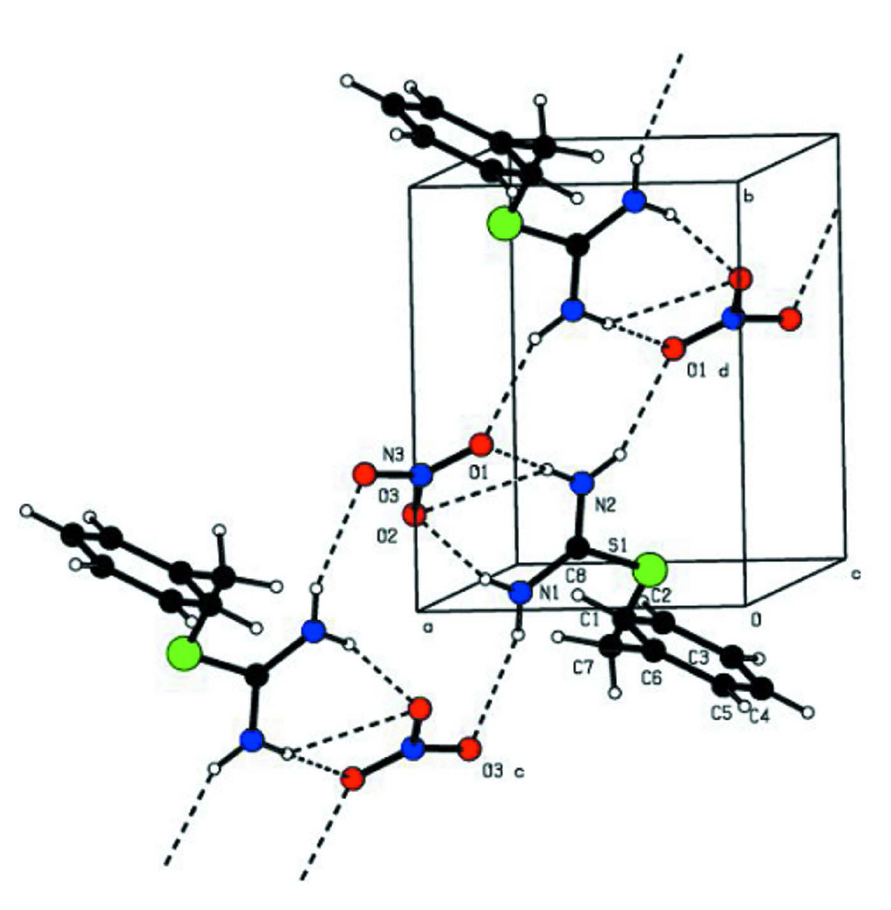
Figure 2 Part of the crystal structure of (I) showing hydrogen bonds as dashed